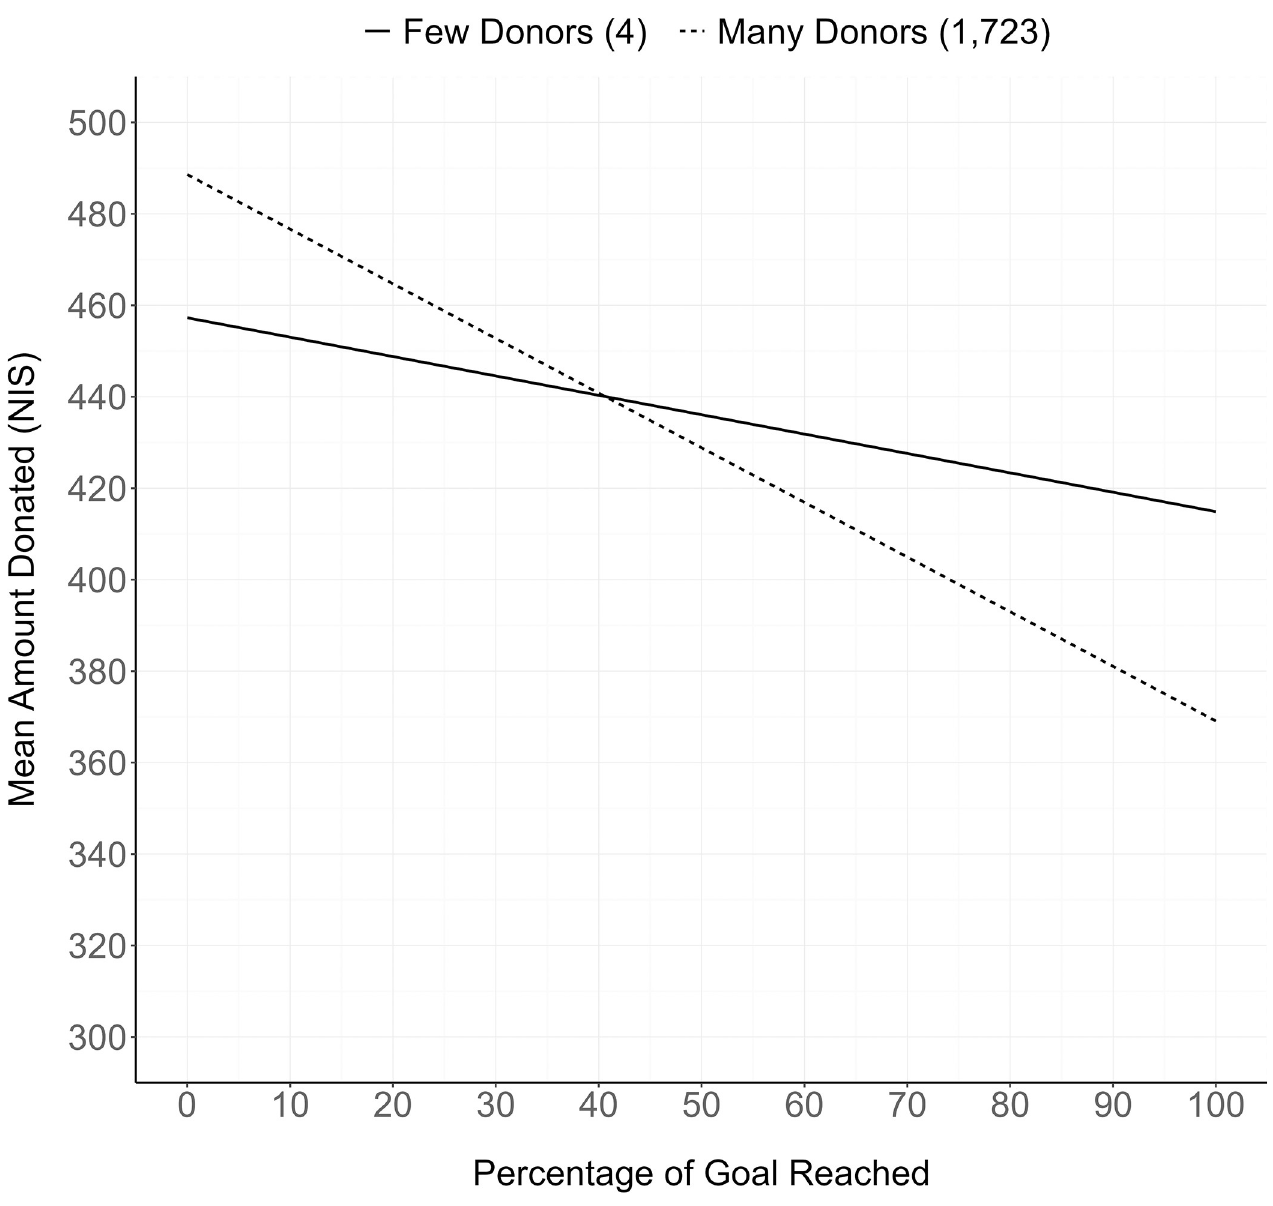
Fig 1. Study 1: Predictive model illustrating the interaction between number of donors and percentage of the goal reached on average donation. Dependent value is not log-transformed for ease of interpretation of the predicted values (y-axis). We used 25th and 95th quantiles of the distribution of number of donors as “few” and “many” donors, respectively. Goal amount is held at its median value in both